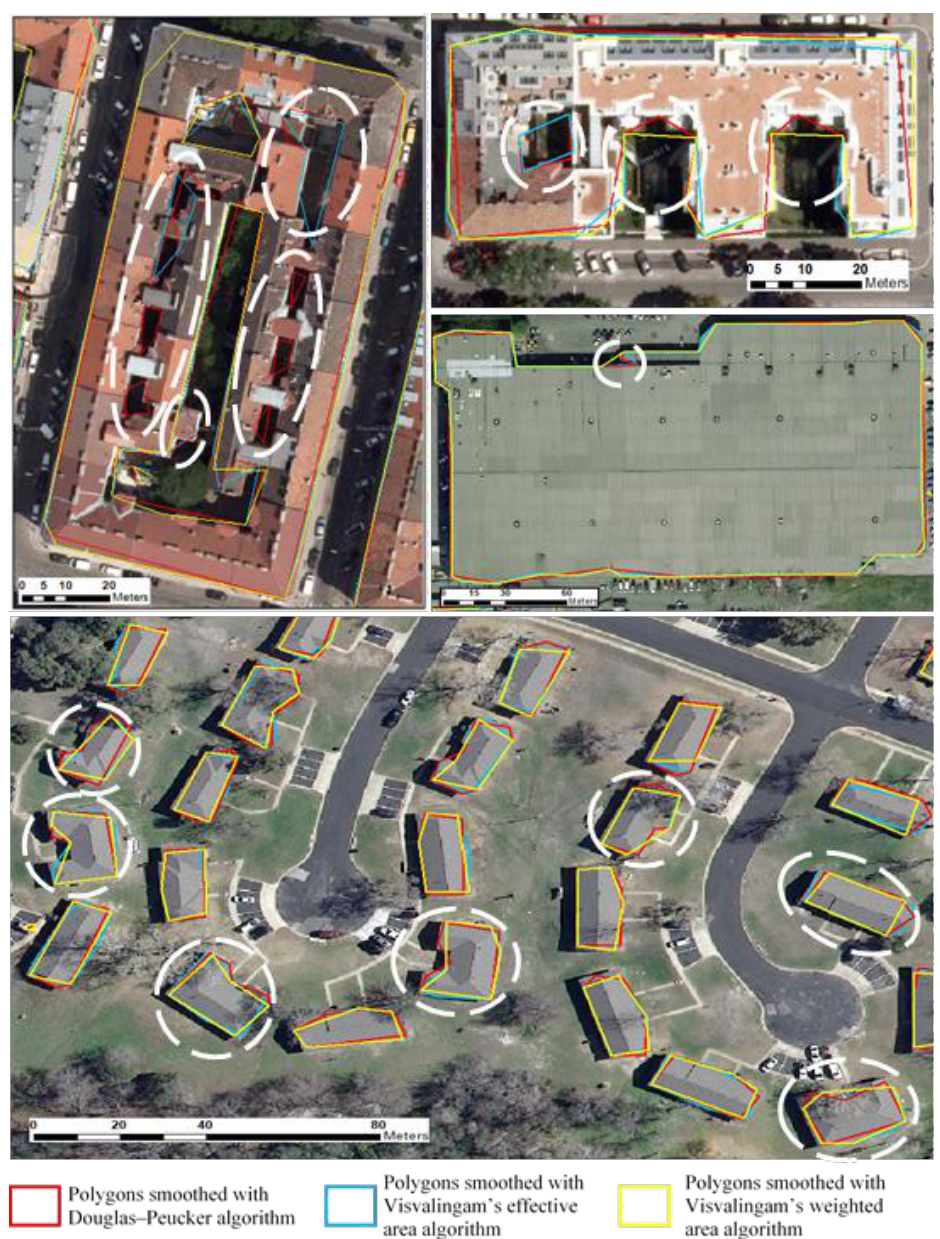
Figure 11. Comparison of polygon smoothing results from three smoothing algorithms for different building types.